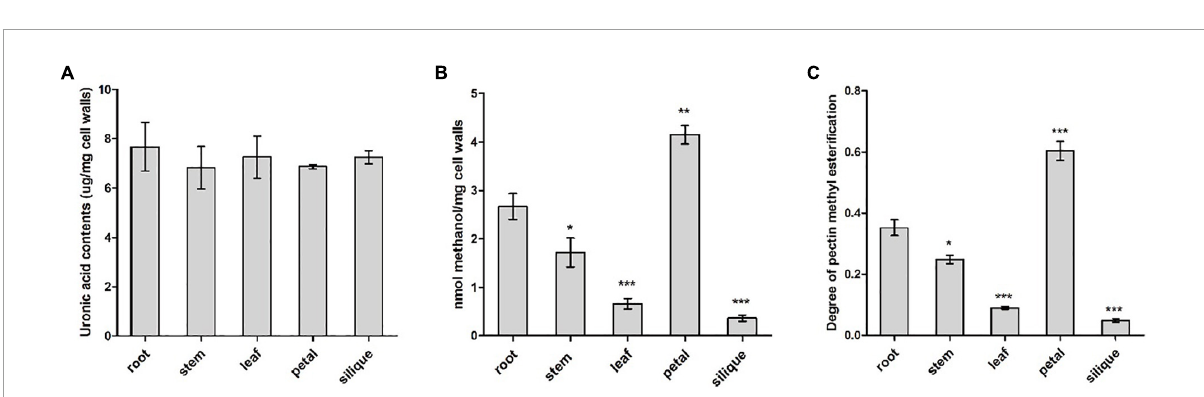
FIGURE8 Biochemical analysis of pectin modification in various tissues including root, stem, leaf, petal and silique at full-bloom stage of B. napus . (A) Analysis of uronic acid content in pectin-enriched fractions of cell walls isolated from different tissues. (B) Quantification of cell wall-bound methanol in different tissues. (C) Degree of pectin methylesterification of cell walls in different tissues. Error bars are mean ± SEM, n = 3. Significant differences between different tissues and root were denoted as follows: *** P < 0.001; ** P < 0.01; * P <